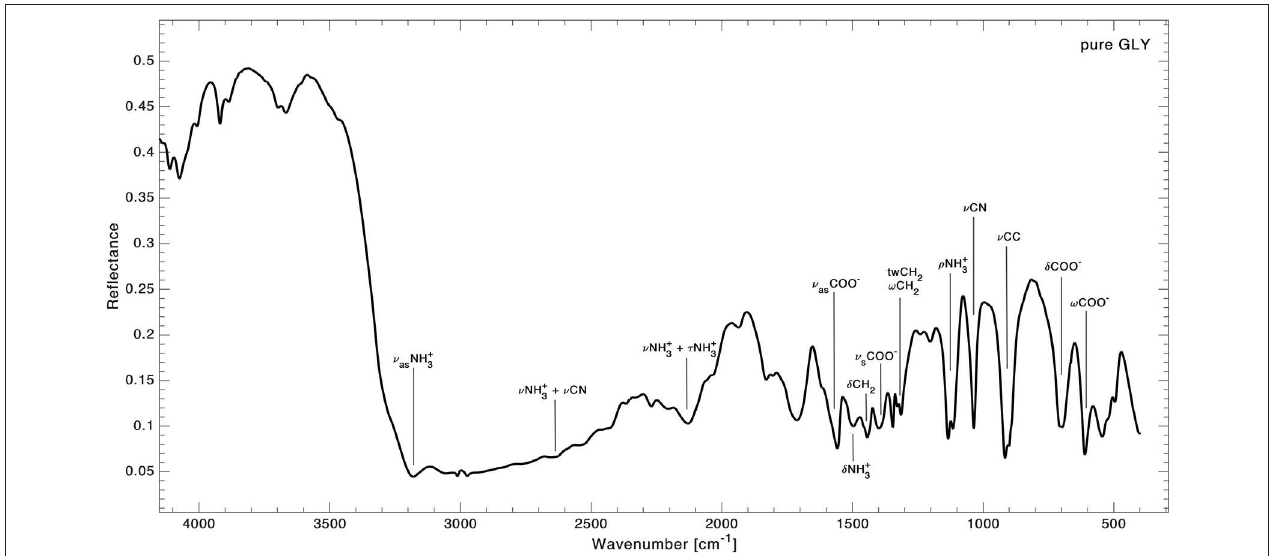
FIGURE 2 | Infrared spectrum of pure GLY in the range 4,000–400 cm − 1 with peaks assignment from Holtom et al. (2005) and Pilling et al. (2013). Vibrational modes legend: ν , stretching; δ , bending; ω , wagging; ρ , rocking; τ , torsion; tw , twisting; s , symmetric; as , asymmetric.